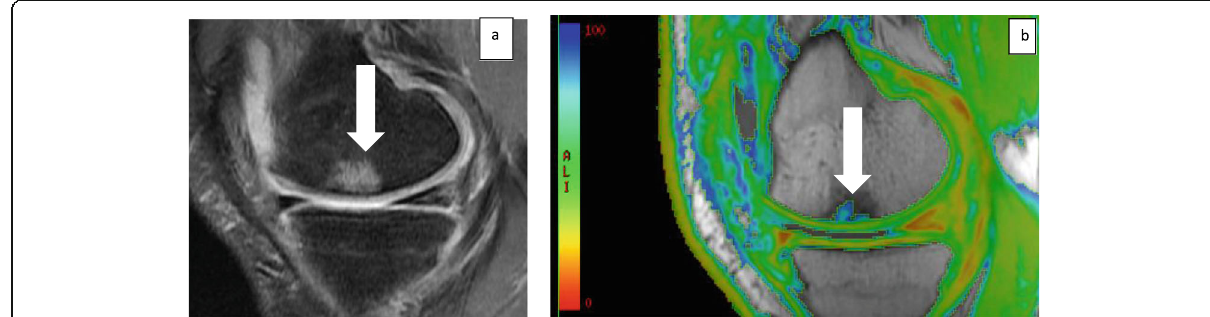
Fig. 5 Decreased bright hyperintense signal of cartilage covering the medial tibiofemoral condyle with denudation and decreased cartilage thickness (star) ( a ), while on T2 mapping, elevated color-coded values of cartilage (superficial zone aqua/blue and deep zone aqua/blue with associated bone degeneration) covering the medial tibio-femoral condyle ICRS grade 4 (arrow) ( b )